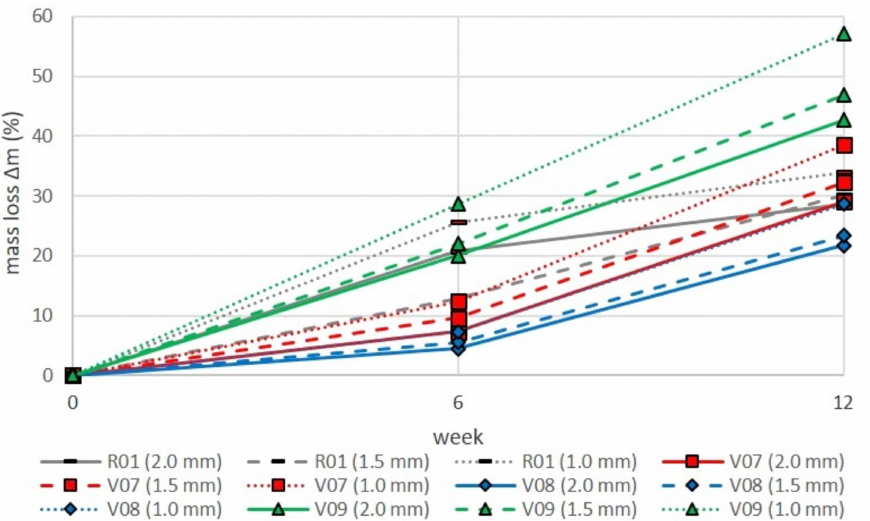
Figure 9. Sample mass loss in comparison of sample thickness and filler types due to industrial composting conditions. Compositions: R01: PLA/PBS blends (7:3) unfilled; V07: plus 15 phr coarse talc; V08: plus 15 phr fine talc; V09: plus 15 phr